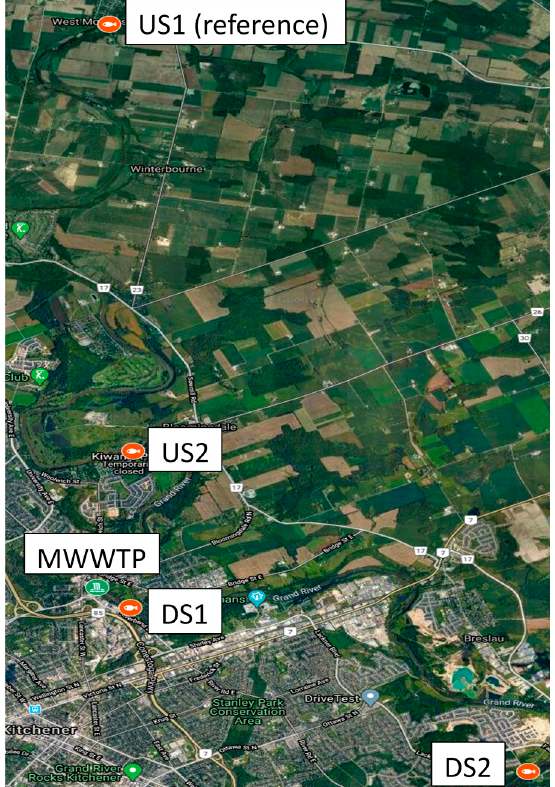
Figure 1. Map of the sampling locations used for collecting the darters used for this study. Orange markers indicate the general locations of capture, green indicates the general location of the effluent outfall. US1, upstream 1; US2, upstream 2; MWWTP, municipal wastewater treatment plant; DS1, downstream 1; DS2, downstream 2 (Google MyMaps; Map data © 2020, CNES / Airbus, First Base Solutions, Landsat / Copernicus, Maxar Technologies).